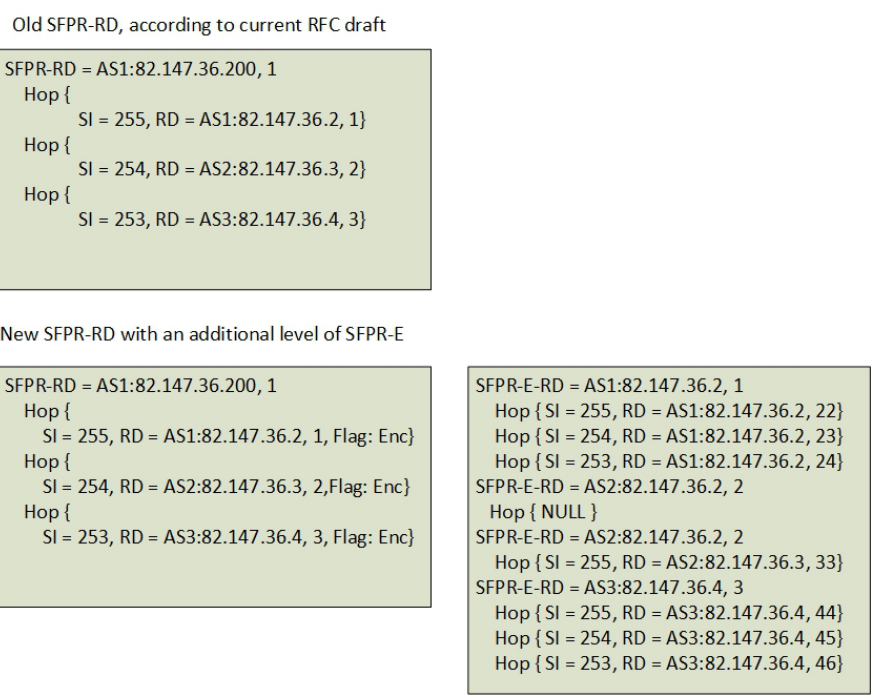
Figure 18. BGP announcement Tier